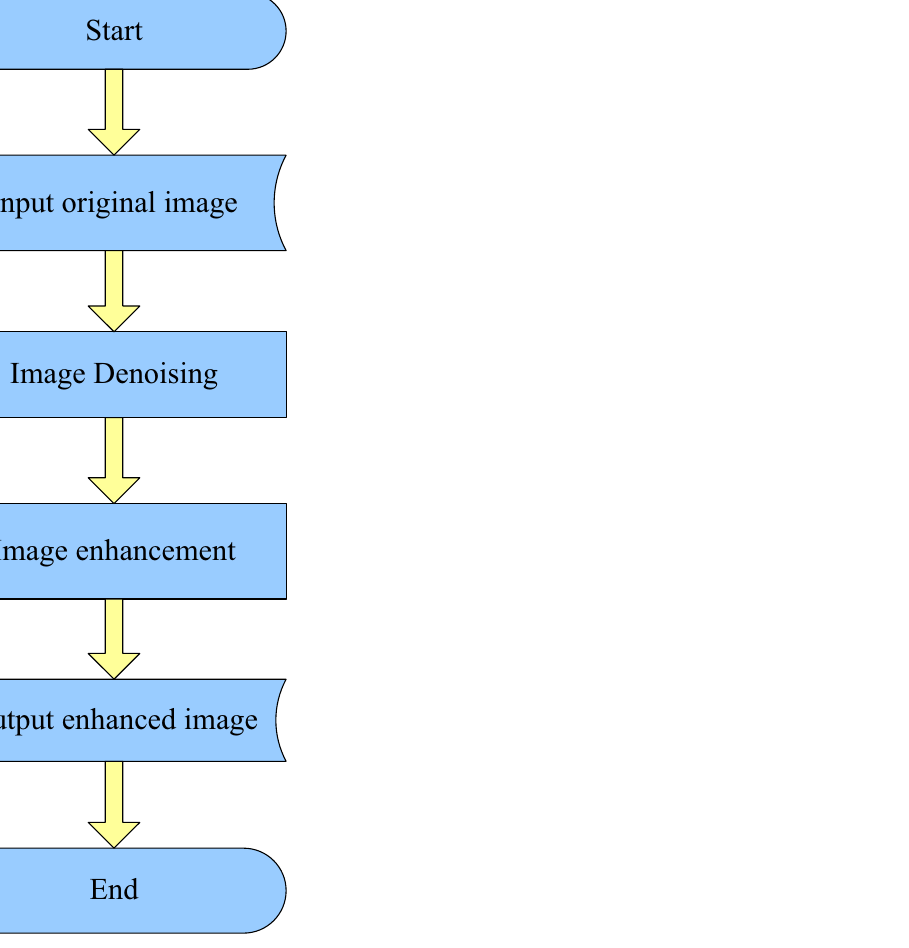
Figure 2. Image enhancement process